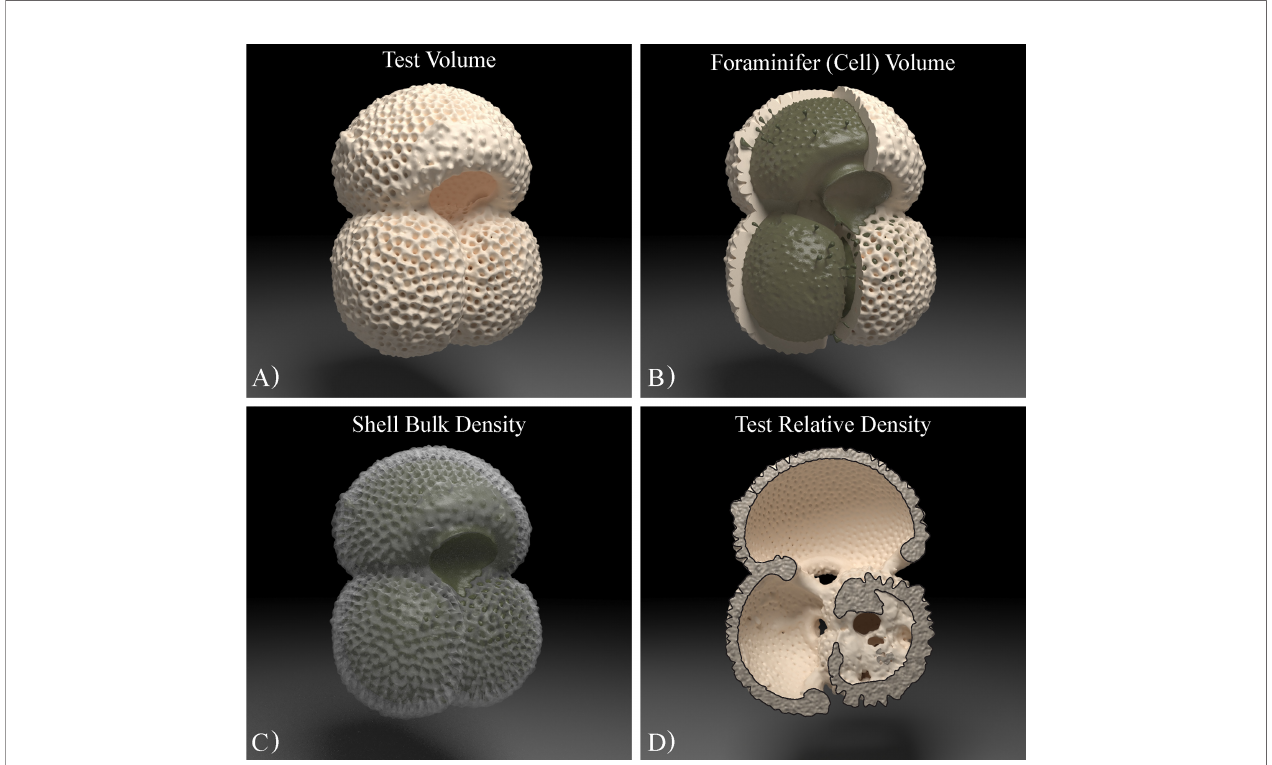
FIGURE 2 | Three-dimensional photo-realistic imagery of a foraminifer using computer graphics rendering illustrating concepts of its skeletal spatial arrangements (excluding spines): (A) Test volume refers to the volume that the calcite biomineral occupies; (B) Cell volume is the mean volume enclosed within the exterior perimeter of the test wall and it is the sum of the calcite test volume and that of the internal cavities that are fi lled with protoplasm in a living cell; (C) Shell bulk density or volume normalized shell weight is the concentration of skeletal material within a foraminifera cell; (D) Test relative density is the test ’ s CT density compared to the CT density of the calcite